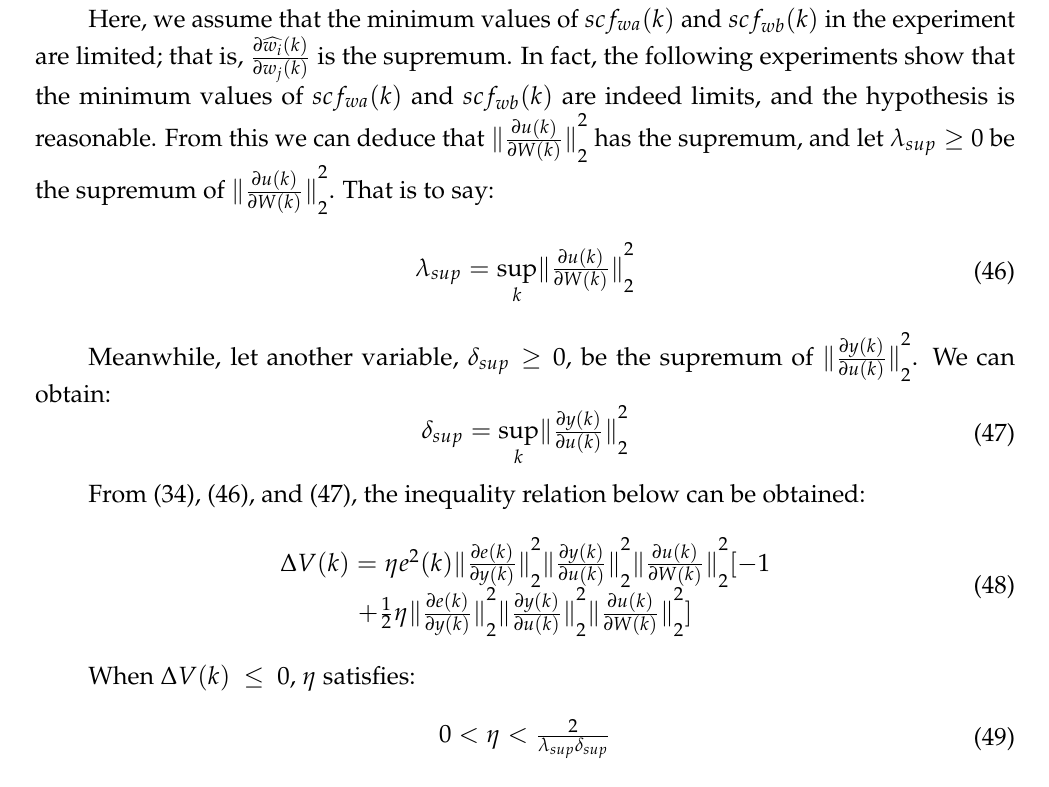
Figure 3. ( a ) The type − 𝑦 function selects a three-dimensional image calculated at every 0.01 step 𝑥 2 size. ( b ) the type − 𝑦 function selects a three-dimensional image calculated at every 1 step 𝑥 2 size.